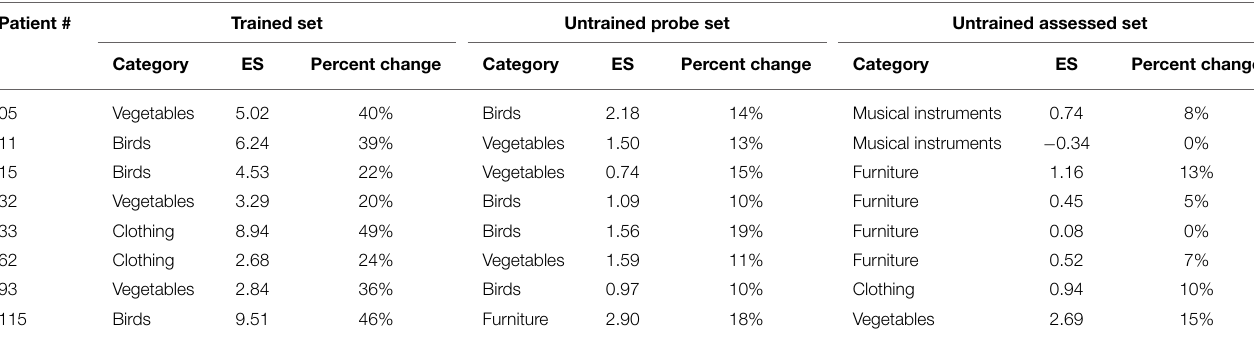
TABLE 3 | Effect sizes (ES) and percent changes for the trained categories across participants compared with untrained but weekly monitored category and untrained but assessed category as a function of rehabilitation. Patient #